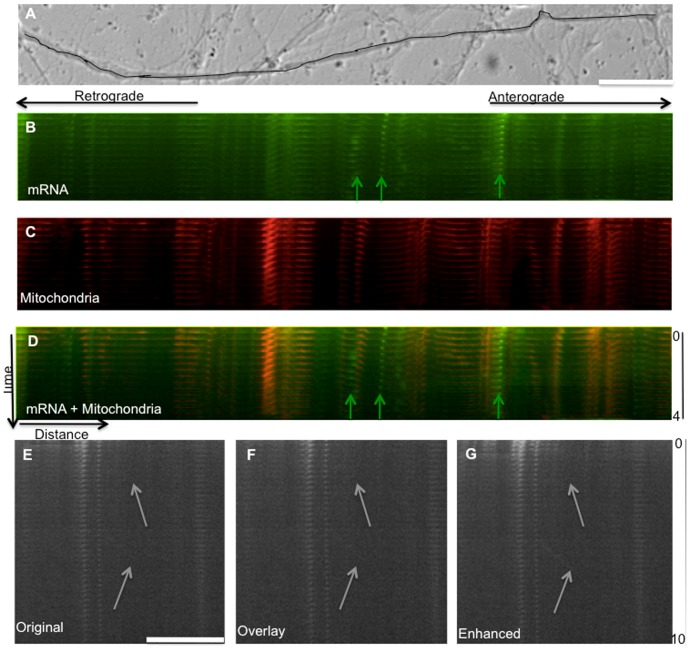
Methods of image analysis.Time-lapse images of neurites were taken under DIC and fluorescence conditions. After classifying the neurite as an axon or dendrite using the DIC image, RNA particles (Syto, green) and mitochondrial particles (Mitotracker, red) were fluorescently labeled. (A) DIC image of a neurite (B) Both mitochondrial (B) and non-mitochondrial RNA and (C) non-mitochondrial kymographs were generated along the length of the neurite visible in the imaging field. Particles that were present in both of the kymographs were concluded to be mitochondrial mRNA whereas particles that were only present in the non-mitochondrial RNA kymograph were considered mRNA particles (arrows). (D) Overlay of mRNA kymograph (green) and mitochondrial kymograph (red). (E) mRNA kymograph without contrast enhancement. (F) Kymograph from (E) following iterative overlay of 50% transparent image to visualize dim moving particles. (G) Kymograph from (E) following contrast enhancement to visualize dim mRNA moving particles. Additional details on enhancement of dim particles are shown in Figure S1. Bar is 20 µm.